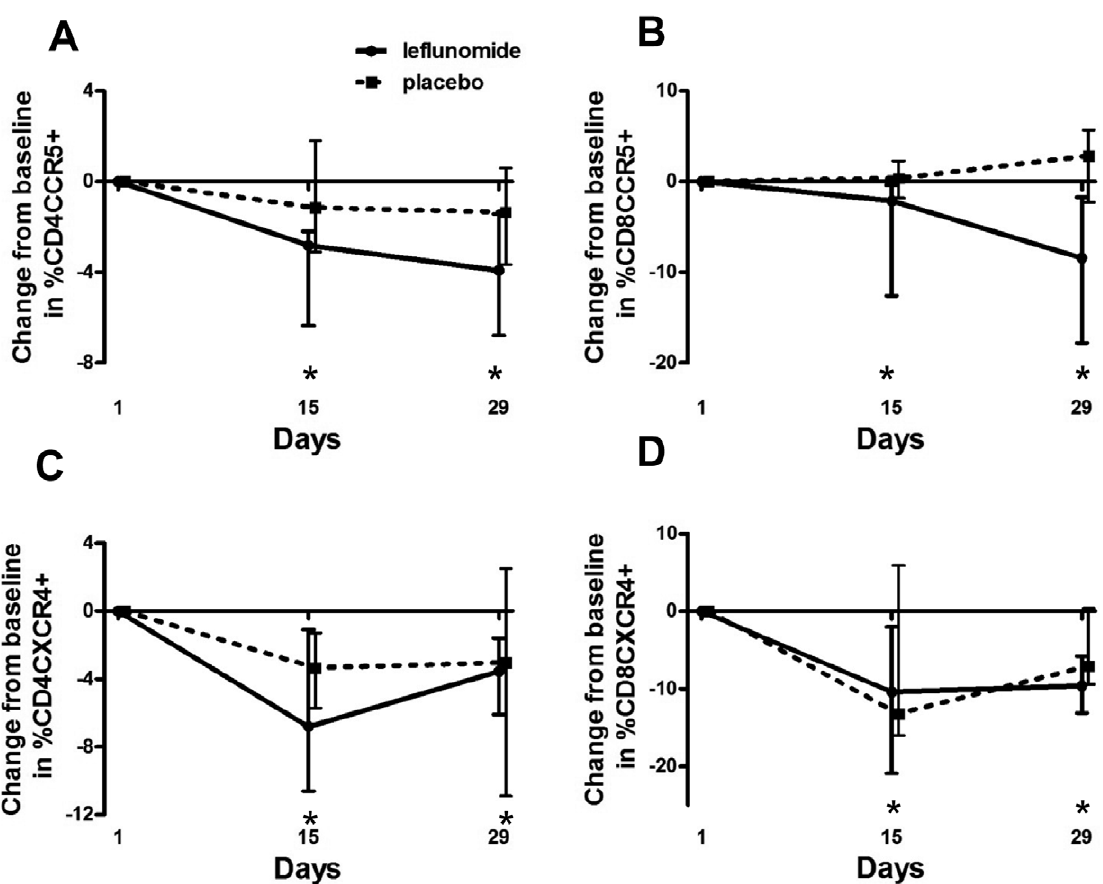
Figure 4. Changes in HIV coreceptor expression. A) Change from baseline in percent of CD4 T cells, and B) CD8 T cells expressing CCR5, median values and interquartile ranges. In the leflunomide group, there were significant decreases in CCR5 expression by CD4 and CD8 T cells at Day 15 and Day 29 (*p-value , 0.05). C) Change from baseline in percent of CD4 and D) CD8 T cells expressing CXCR4; median values and interquartile ranges. In the leflunomide group, there were significant decreases in CXCR4 expression by CD4 and CD8 T cells at Day 15 and Day 29 (*p-value , 0.05).